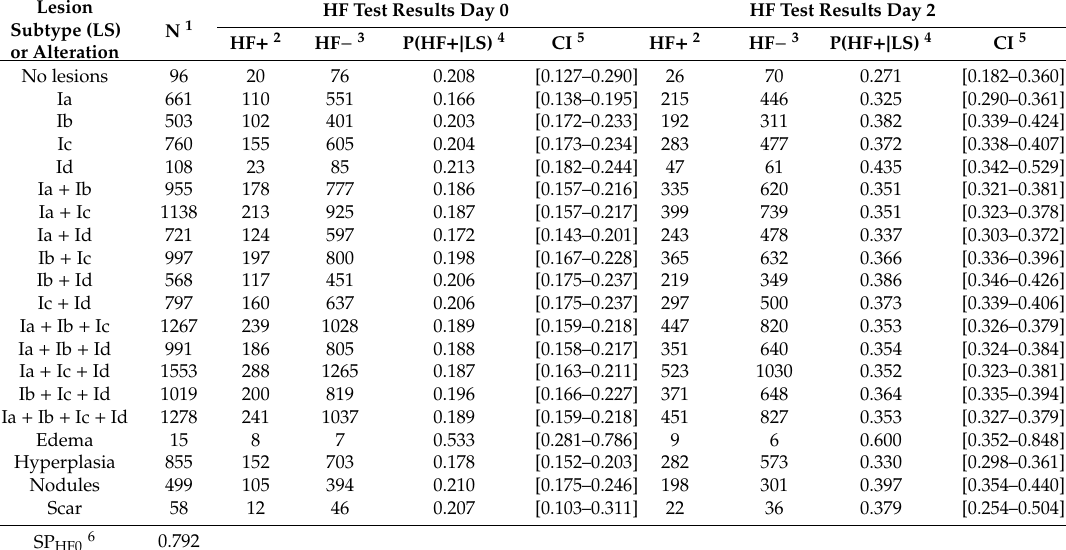
Table 4. Descriptive results of Hemo-Fec ® (HF) on slaughtered cattle the same day the fecal samples were obtained (Day 0) and two days after fecal sampling (Day 2). Cow was the study unit, but the individual cow may occur in multiple groups, e.g., group “Ia” includes all cattle with subtype Ia lesions along with those with other subtypes, while group “Ia + Ib” includes all cattle with at least Ia and Ib lesions. The diagnostic sensitivity with the corresponding confidence interval (CI) for both days are